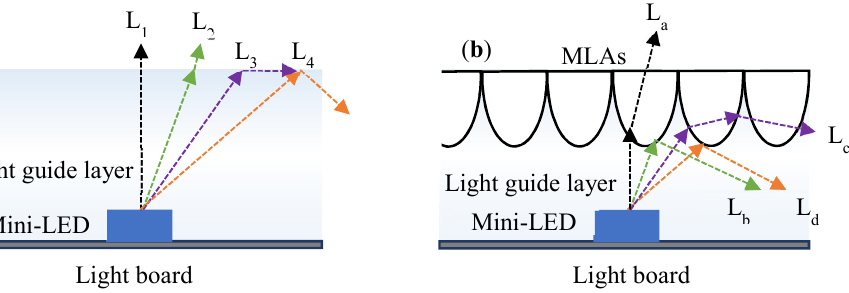
Figure 6. Ray tracing of the light guide layer combined with the MLA module: ( a ) ray tracing without MLAs; ( b ) ray tracing with MLAs.